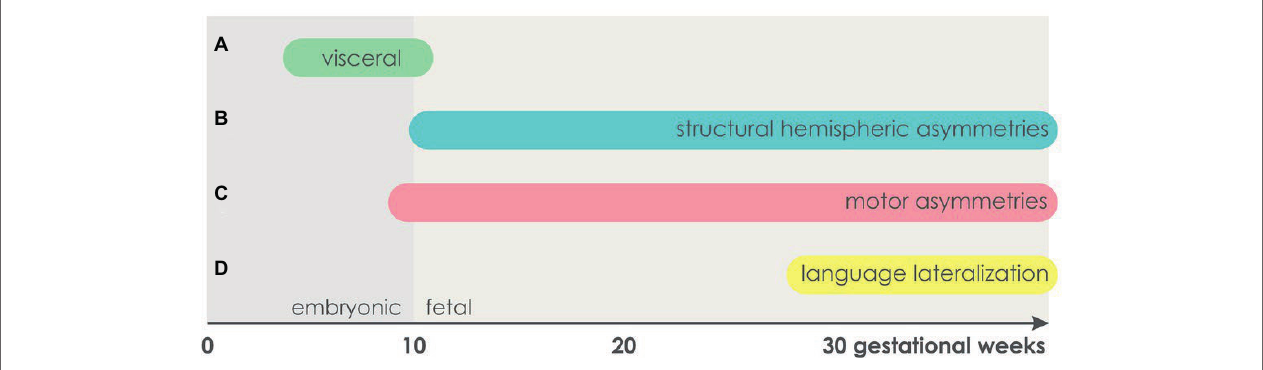
FIGURE 2 | The time course of asymmetry development. (A) Visceral asymmetries. (B) Structural hemispheric asymmetries. (C) Motor asymmetries. (D) Language